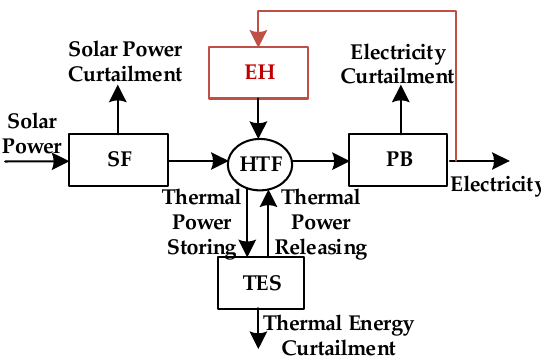
Figure 2. Simplified energy flow in CSP station with thermal energy storage (TES) and EH.